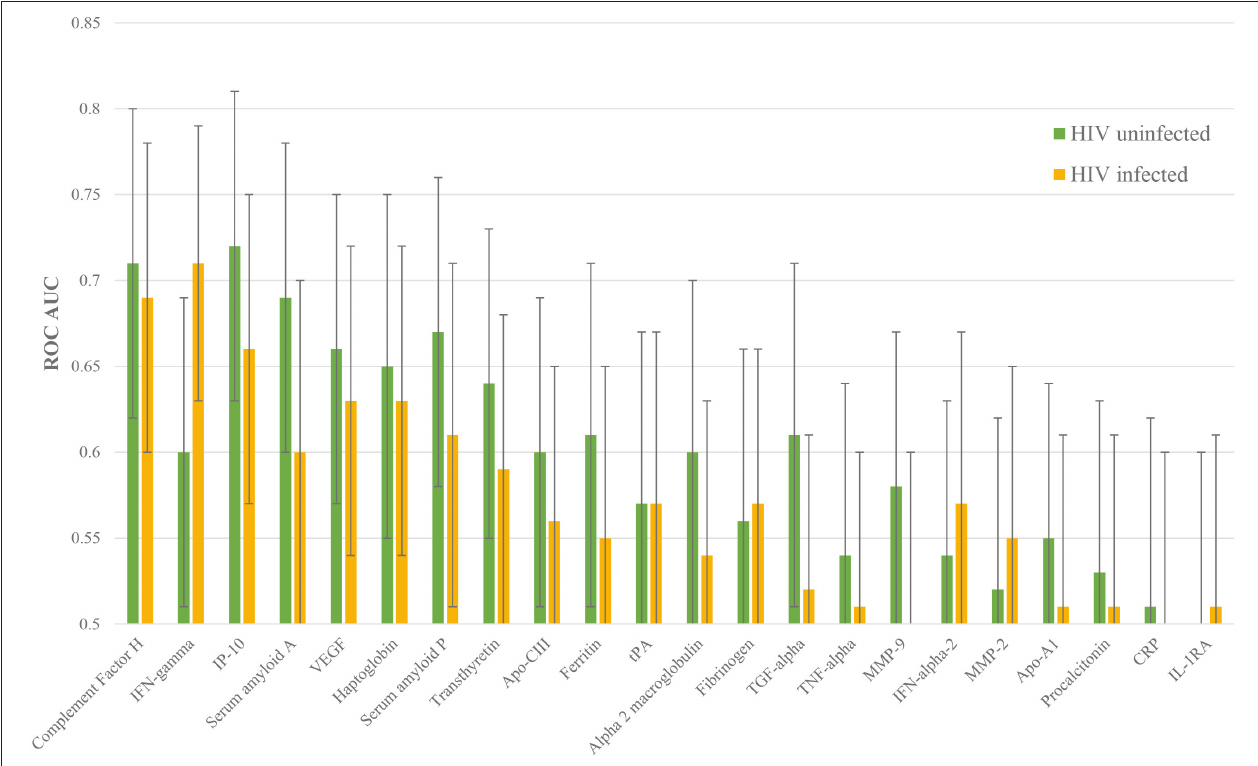
FIGURE 3 | Individual ROC AUCs for each of HIV uninfected and infected halves of this sample of the ILULU-TB cohort. Green bars: distinction of TB, HIV– from OD, HIV–; yellow bars: TB, HIV + from OD, HIV + .